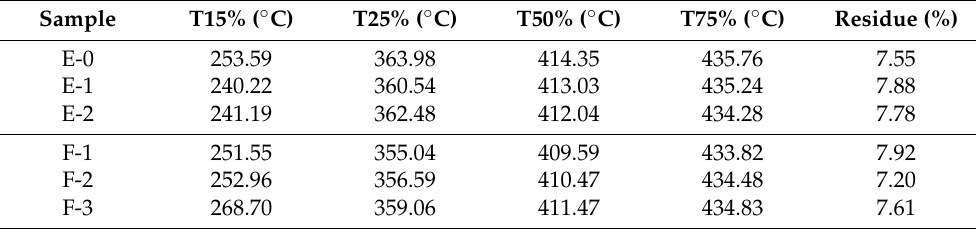
Table 2. Degradation temperatures at different weight loss percentages.